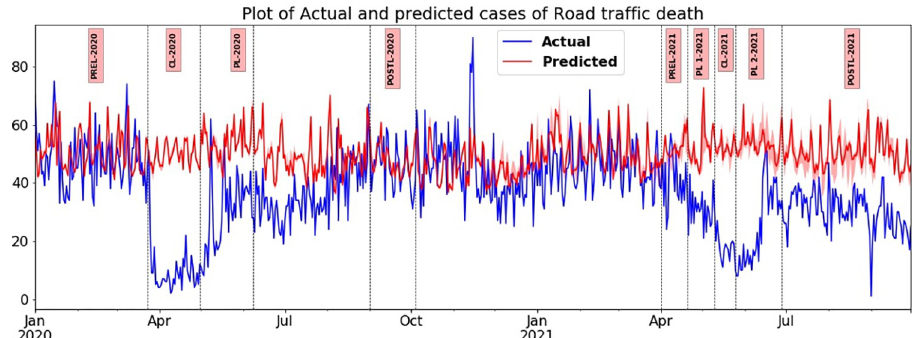
Fig 4. Plot of daily number of road traffic deaths (RTD) in TN actual versus predicted during various phases of wave one and wave two in 2020 and 2021.